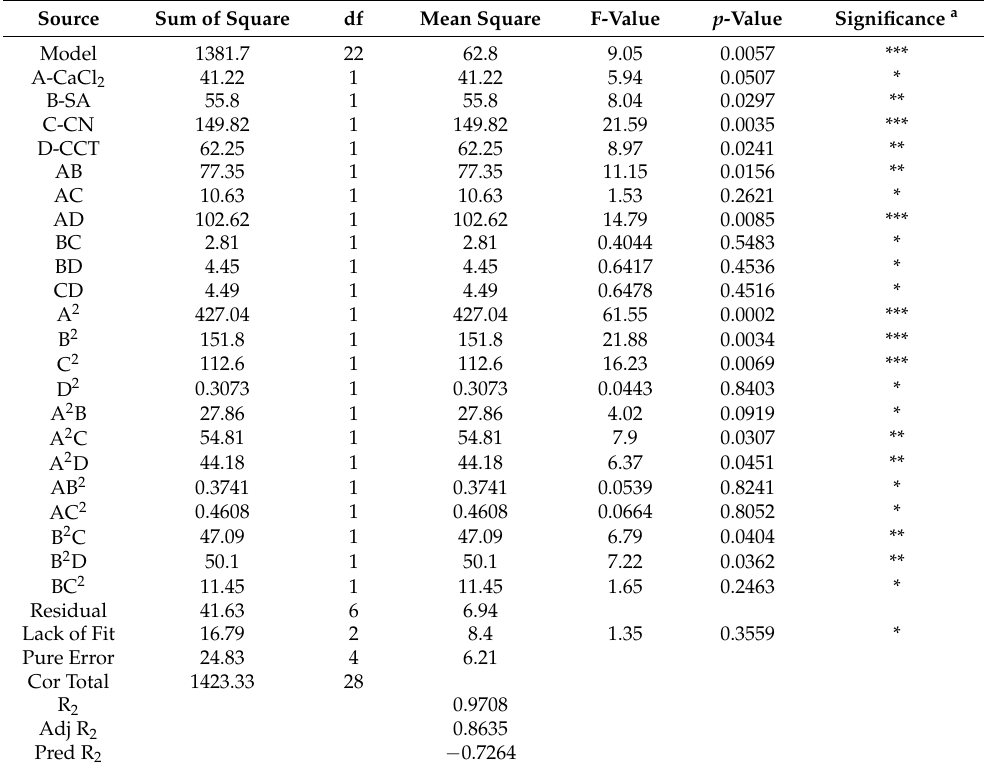
Table 2. Analysis of variance for encapsulation efficiency of